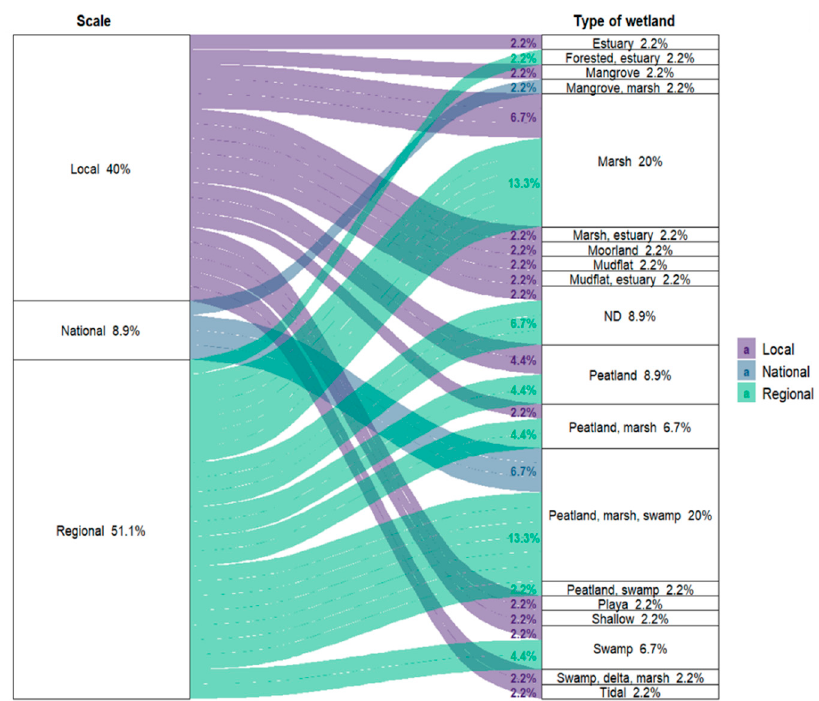
Figure 7. Percentage of papers depending on the scale used and type of wetland plus their distribution based on the relationship between these two parameters.